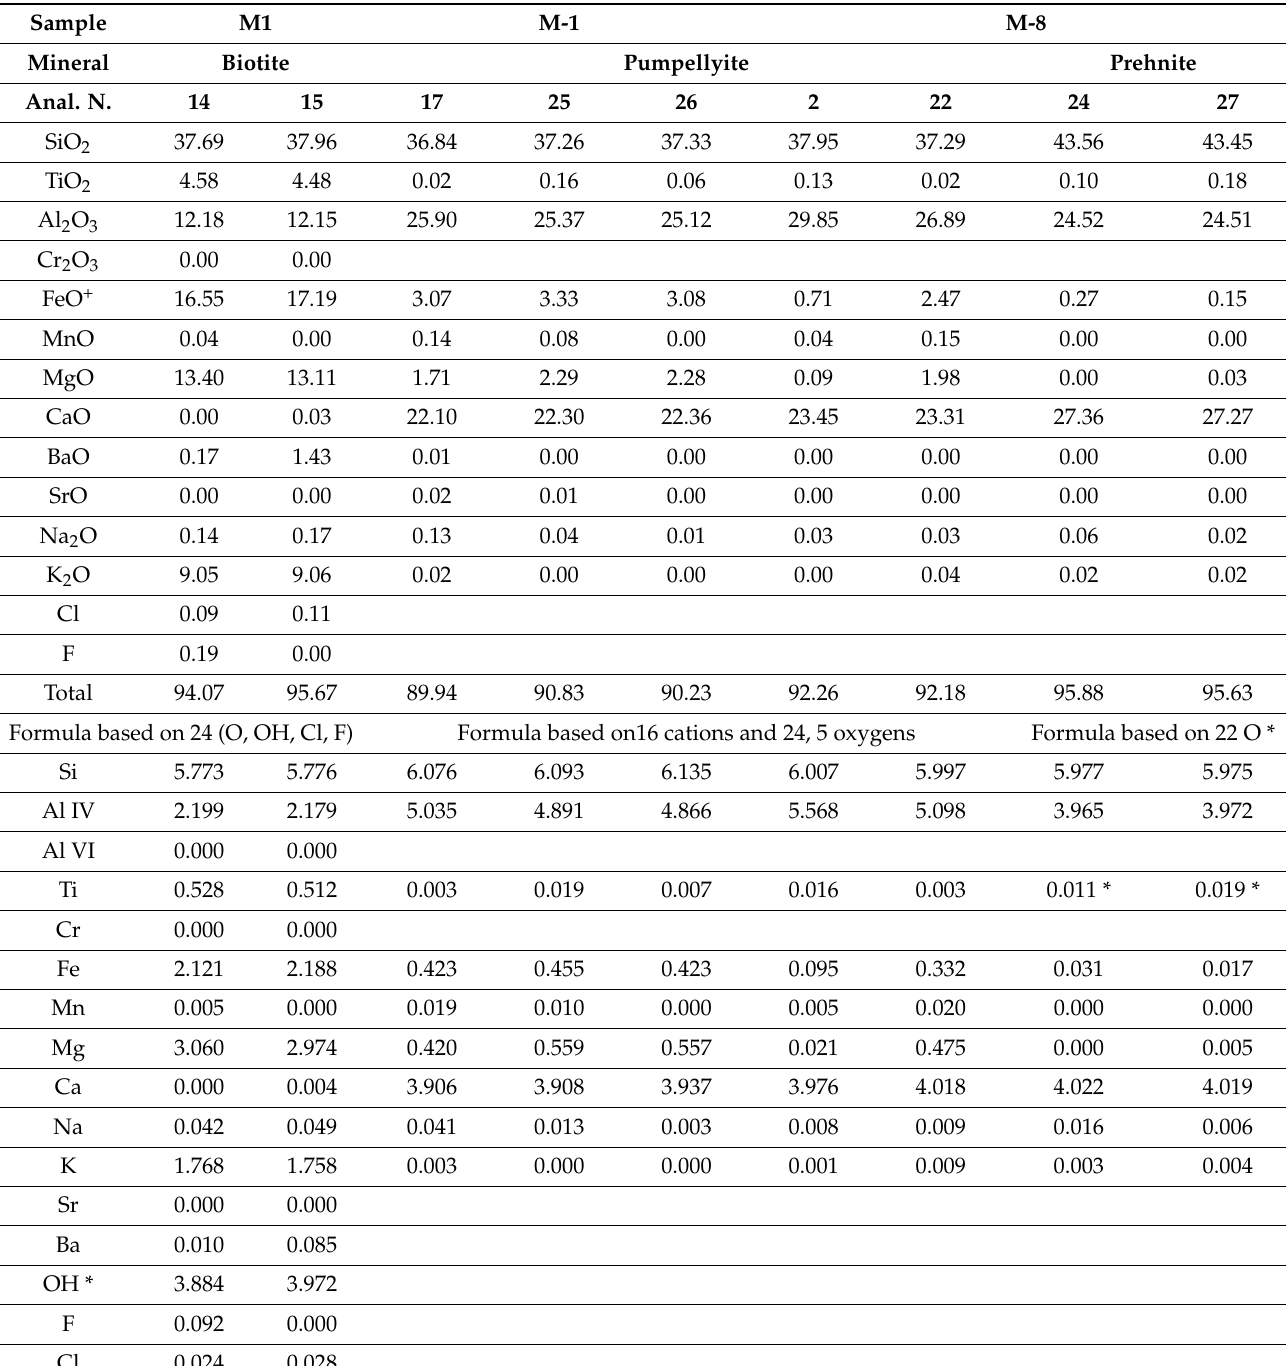
Table 4. Selected analyses of biotites, prehnites, and